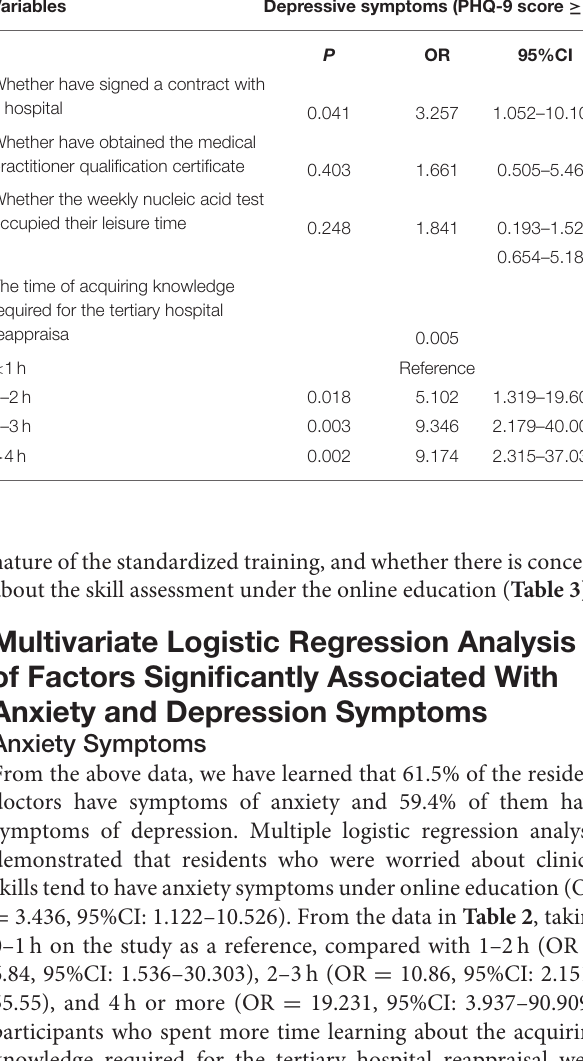
TABLE 3 | Multivariate logistic regression analysis of variables related to depressive symptoms.